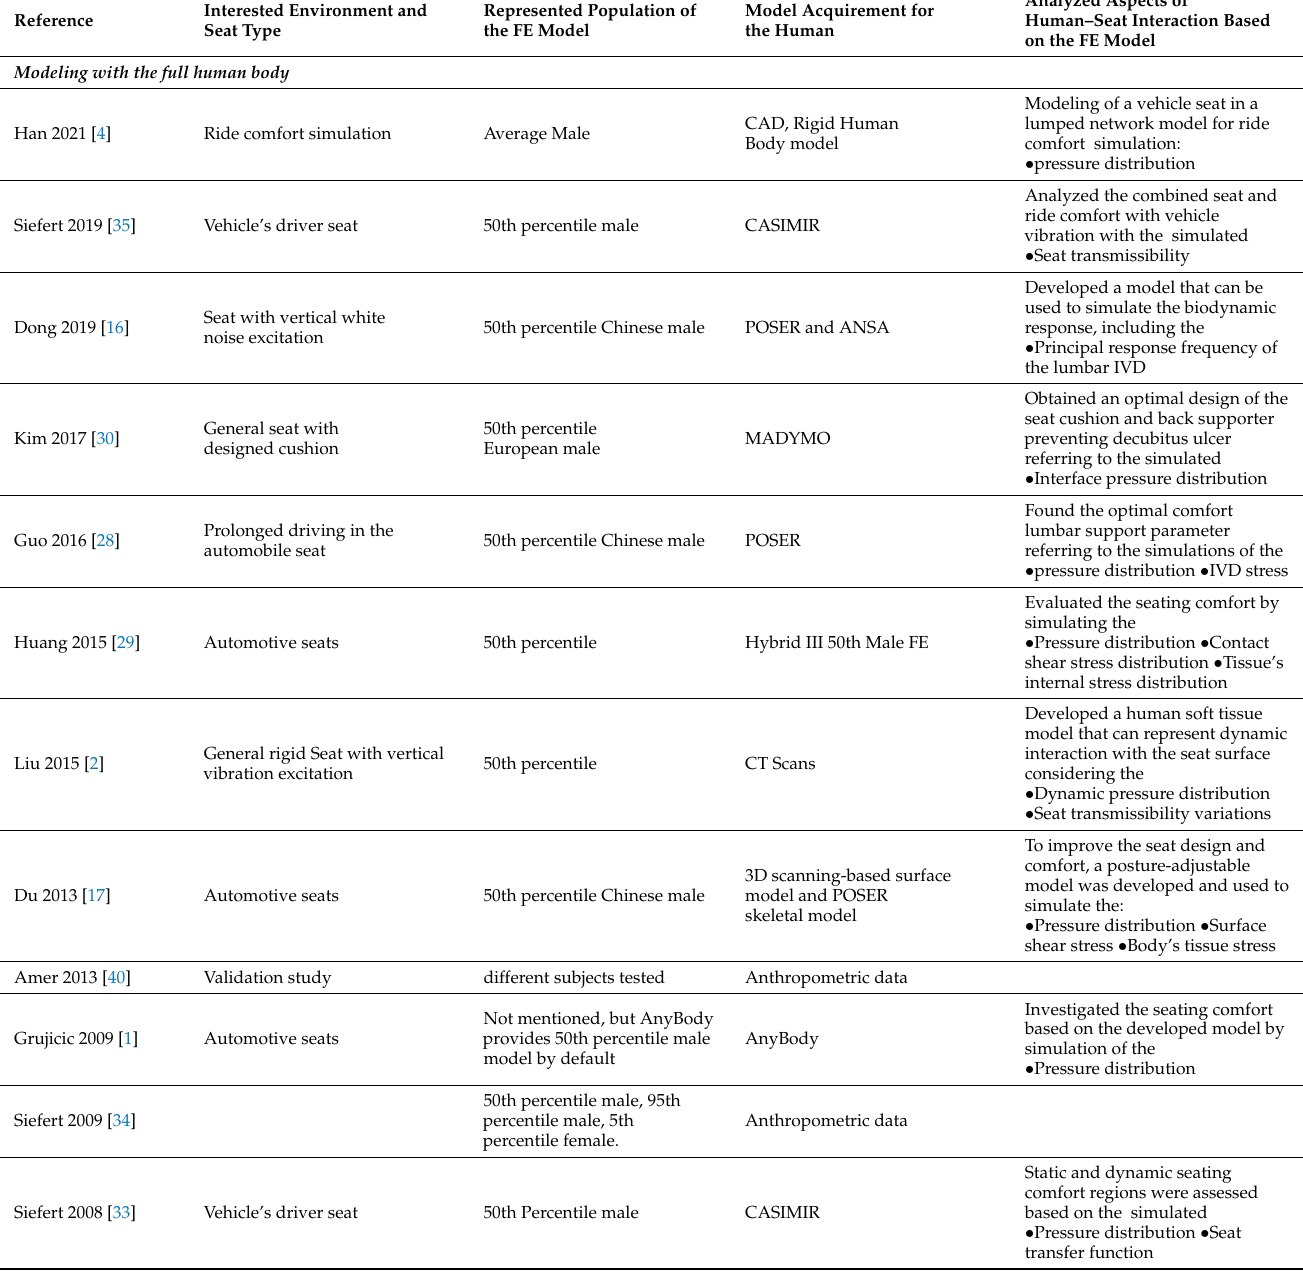
Table A1. Basic study information of the 36 selected papers for this systematic